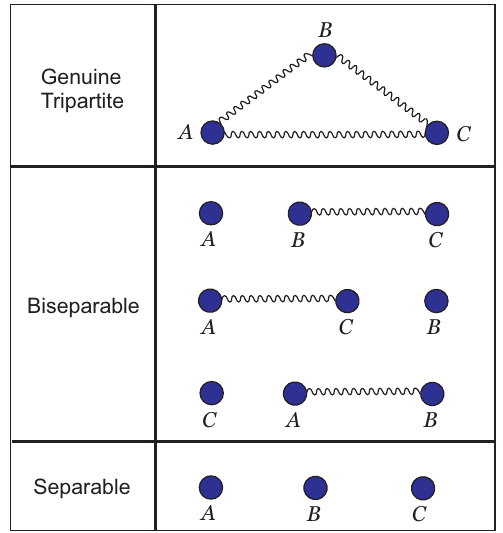
Figure 1. Possible scenarios of three-qubit quantum states. From top to bottom: First, Genuine tripartite entanglement, where all qubits are in an entangled state. Second, biseparable partitions, where only two qubits are entangled. Third, full separable